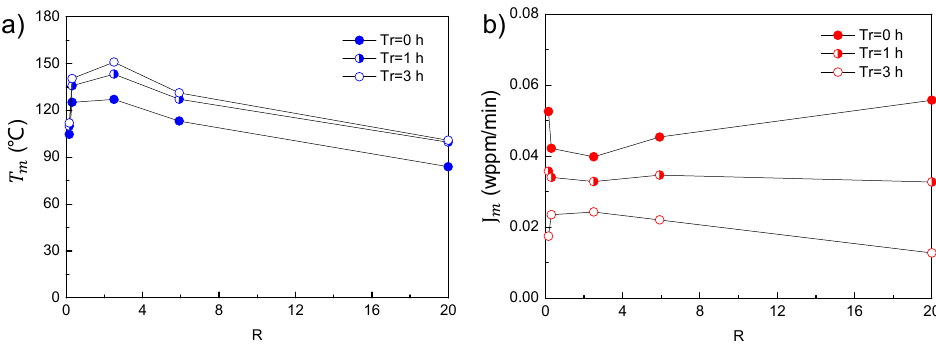
Figure 10. Effect of specimen geometry and rest time on ( a ) the peak temperature and ( b ) the peak flux, using identical parameters as those in Figure 3. The specimen volume was controlled at constant values, while the ratio of specimen height/diameter ( R ) was varied.